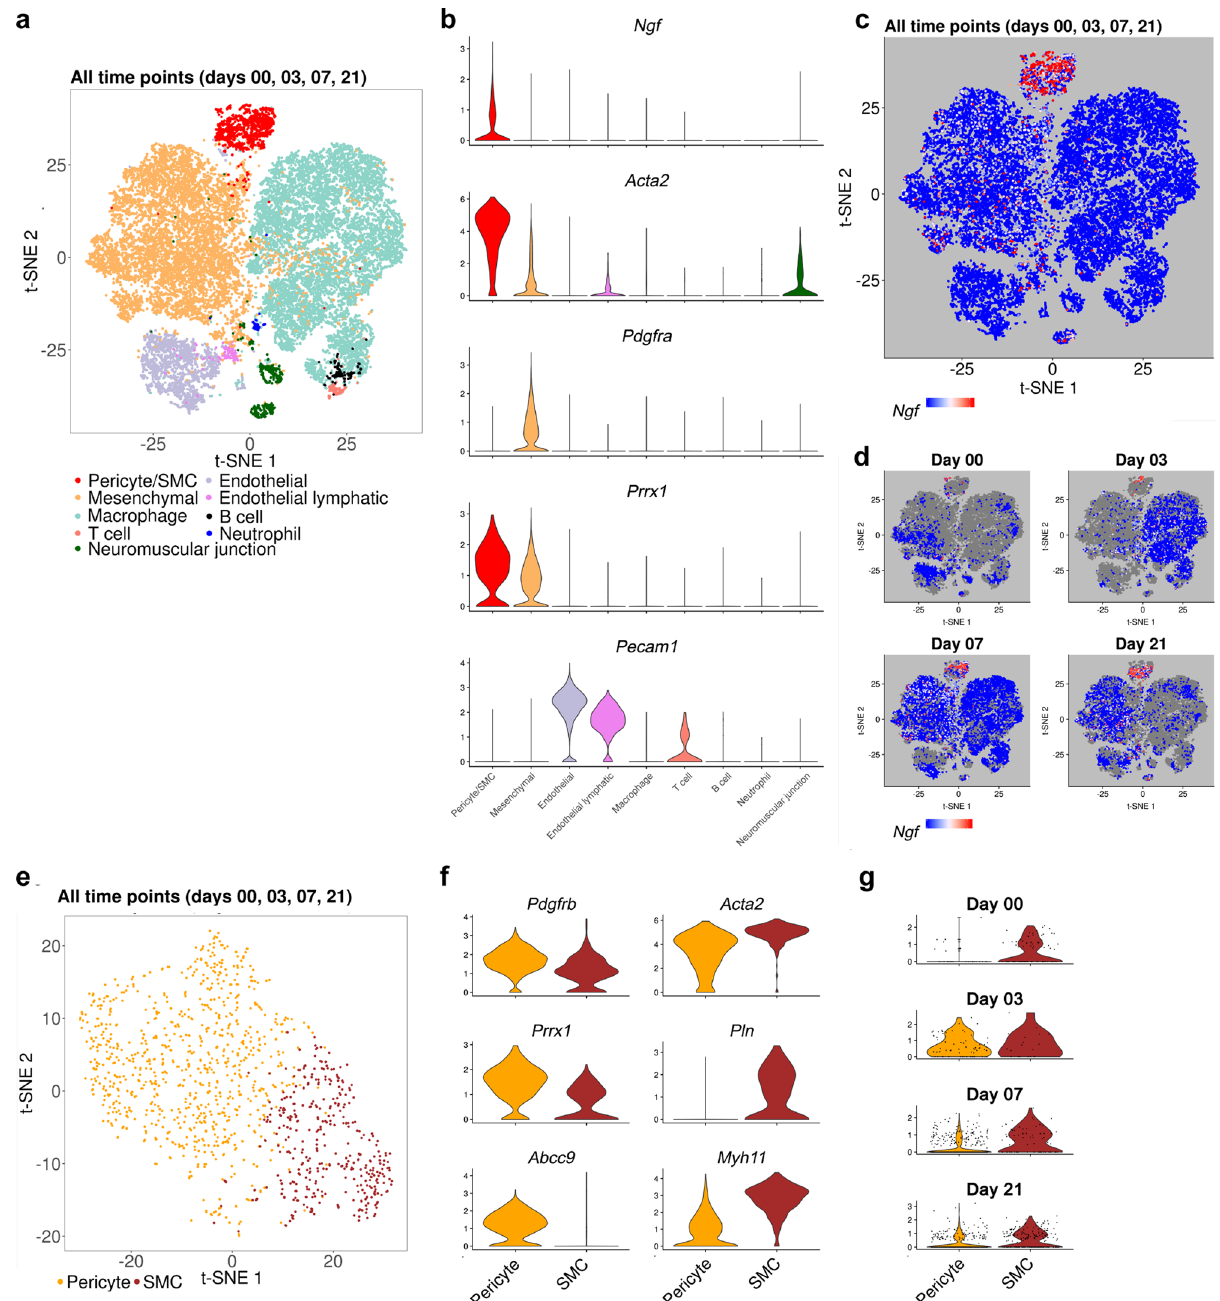
Fig. 3 The primary sources for nerve growth factor (Ngf ) during early HO evolution are pericytes and vascular smooth muscle cells (SMCs). C57BL/6J mice were subjected to HO induction, and the injury site was examined by single-cell RNA-sequencing (scRNA-seq) up to 21 days thereafter. a , b t-Distributed stochastic neighbor embedding (t-SNE) plots of pooled cells from four time points after HO induction (including days 0, 3, 7, and 21), along with violin plots to demonstrate characteristic gene markers among nine cell clusters. See Supplementary Fig. S3 for additional gene markers that typify each cluster. c , d Ngf expression within t-SNE plots either c among pooled across all timepoints or d at each time point individually. e Subclustering among the pericyte/ SMC cell population by t-SNE plot reveals two main cell populations (cells pooled across all timepoints). f Genes of interest de fi ne the two sub-population as pericytes (yellow) and vascular SMCs (brown). g Violin plots demonstrating Ngf expression across time in pericyte and vascular SMC subclusters. Both pericytes and SMCs demonstrate Ngf expression, with vascular SMCs providing the most basal Ngf in uninjured tissue (day 0). Cells isolated from N = 4 animals for days 0, 7, and 21; N = 3 animals for day Inhibition of TrkA abrogates HO . Having identi fi ed the central OCN immunoreactivity was observed among Ad-Cre-treated tenotomy sites (Fig. 5t,u). Thus, Ngf deletion impairs axonal role of NGF, we next set to validate that NGF exerts its effects on ingrowth into the injured site, with a concomitant reduction in nerve ingrowth and secondarily stem cell fate decisions via its the pathologic process of trauma-induced heterotopic bone for- high-af fi nity receptor TrkA. First, we used a previously validated mation, which phenocopies proximal nerve transection. chemical – genetic approach, in which TrkA signaling is acutely